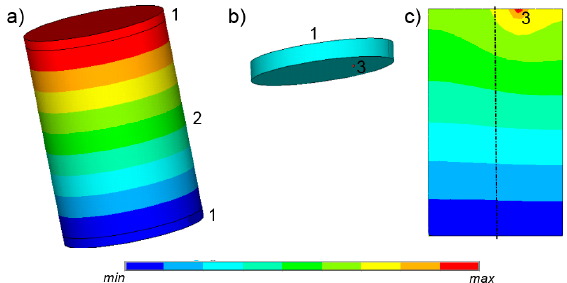
Figure 8. Distribution of the electric potential in the model not including ( a ) and including the gas bubble ( c ) and the bubble model on the surface of the upper electrode ( b ). 1—electrode; 2—discharge area; 3—gas bubble.